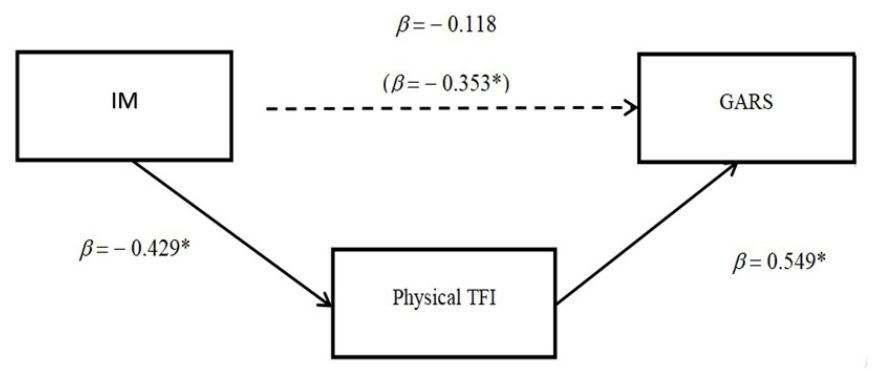
Figure 1. Mediation model among GARS (outcome), IM (predictor), and Physical TFI